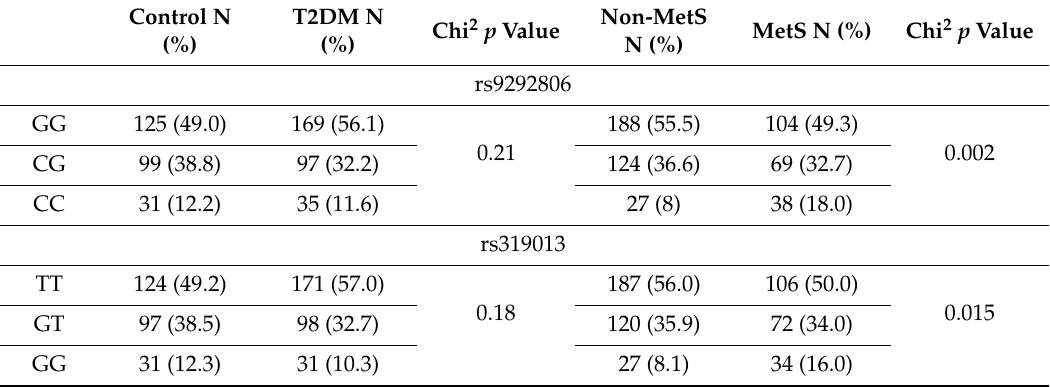
Table 3. Genotype frequency distribution of PLCXD3 SNPs in Control vs. T2DM and Non-MetS vs. MetS subjects.